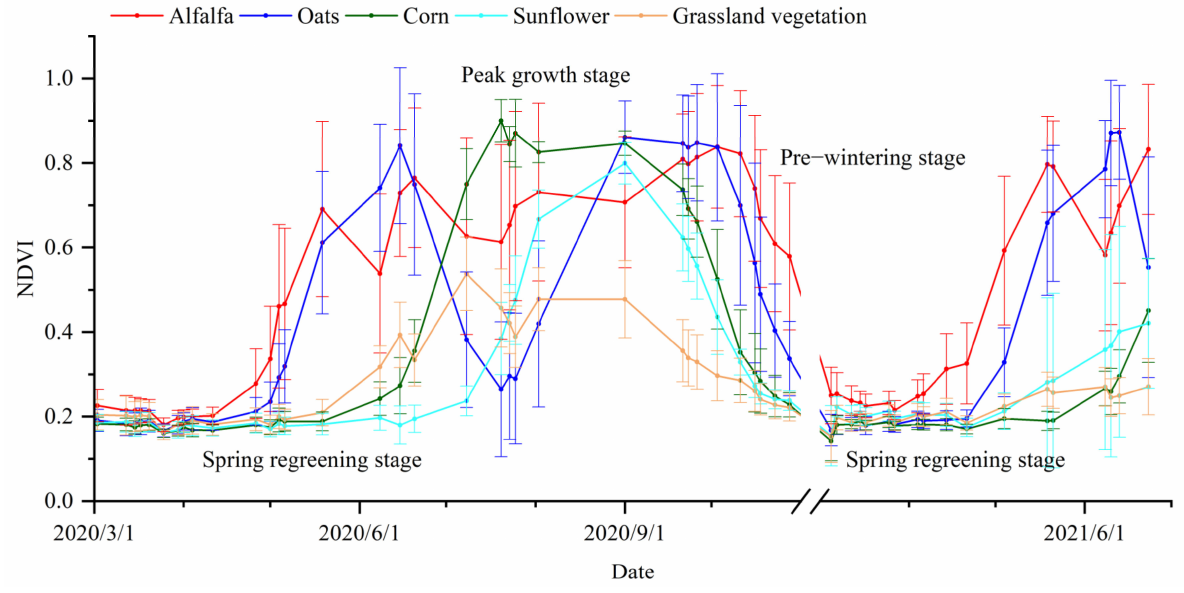
Figure 4. NDVI values of different vegetation types derived from the Sentinel ‐ 2 data from January